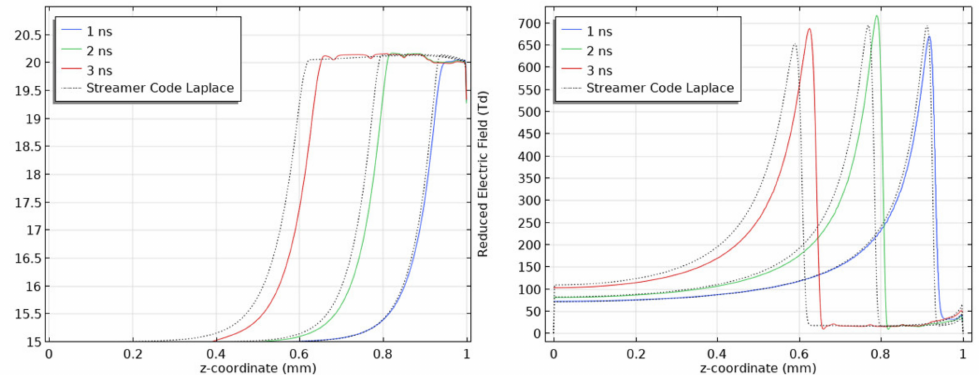
Figure A2. Electron density variation ( left ) and electric field distribution ( right ) on streamer axis at times t = 1, 2, and 3 ns for COMSOL ™ model (solid line) and reference work by PRHE team, Laplace lab [33] (dotted line). No background ionization and no adaptive mesh used.